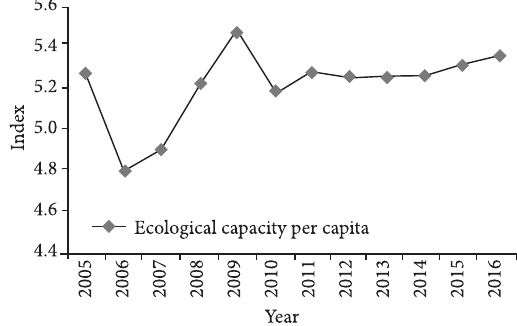
Figure 2. Variation trend of ecological footprint per capita Figure 3. Variation trend of ecological capacity per